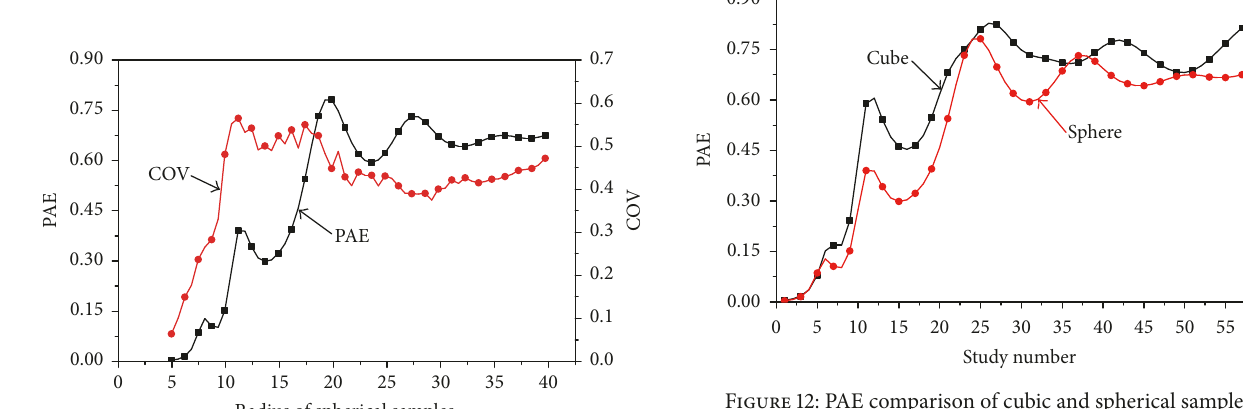
Figure 9: COV of different shape samples.